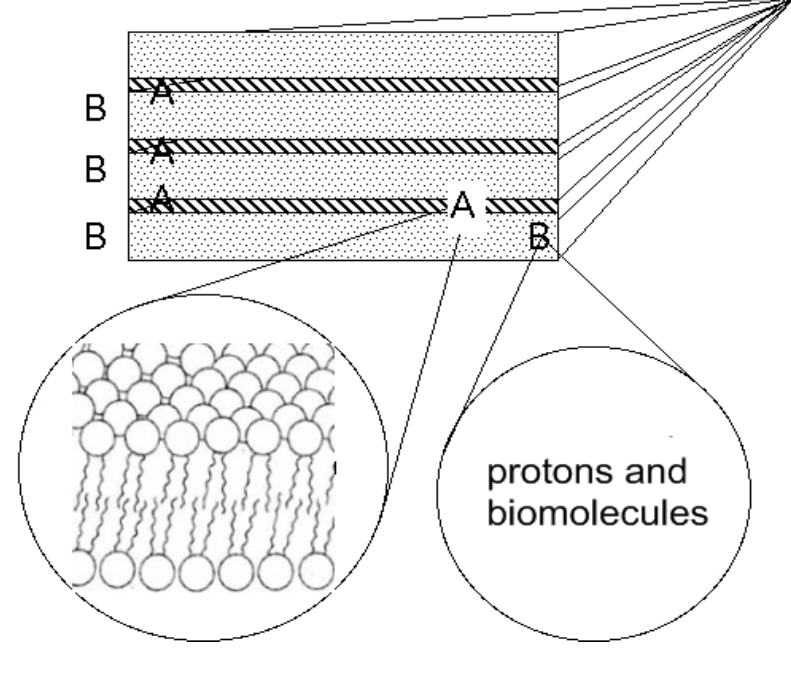
Figure 4. The schematic picture of the model made of a superlattice of lipid bilayers (portion A) intercalated by liquid water layers with itinerant biomolecules and protons (portion